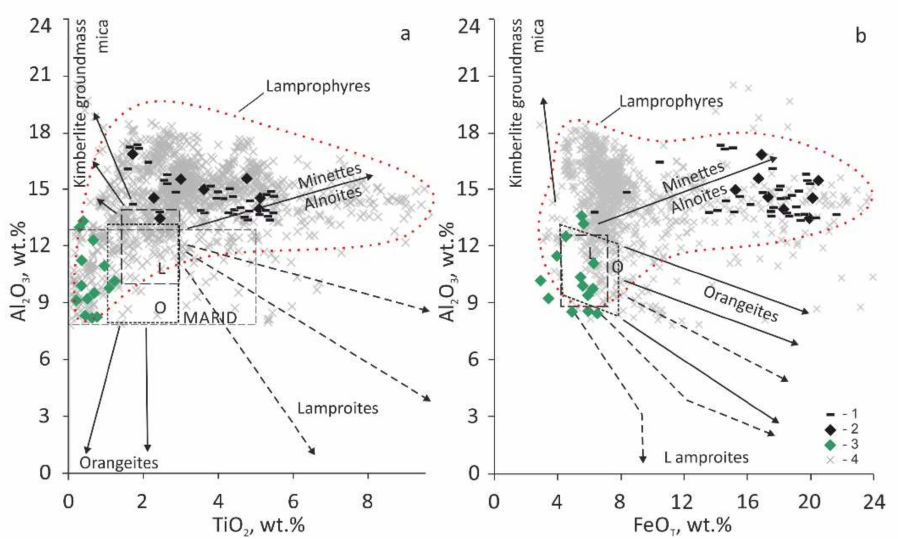
Figure 5. Al 2 O 3 vs. TiO 2 ( a ) and FeO T ( b ) in micas from Sputnik pipe (1), Aldanskaya dyke (2) and mica inclusions in Cpx rims from the Aldanskaya dyke (3); blocks mark compositions of orangeite